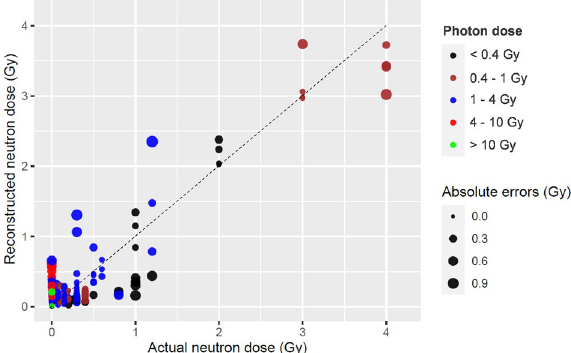
Figure 6. Visualization of the errors in neutron dose reconstruction by the random forest algorithm on testing data. Each circle represents a blood sample. These data points are the same as those in Fig. 5C, but absolute errors in neutron dose reconstruction are shown by circle size and the photon dose is shown by circle color (black: < 0.4 Gy, brown: 0.4–1 Gy, blue: 1–4 Gy, red: 4–10 Gy, green: > 10 Gy). The dashed line represents theoretically perfect 1:1